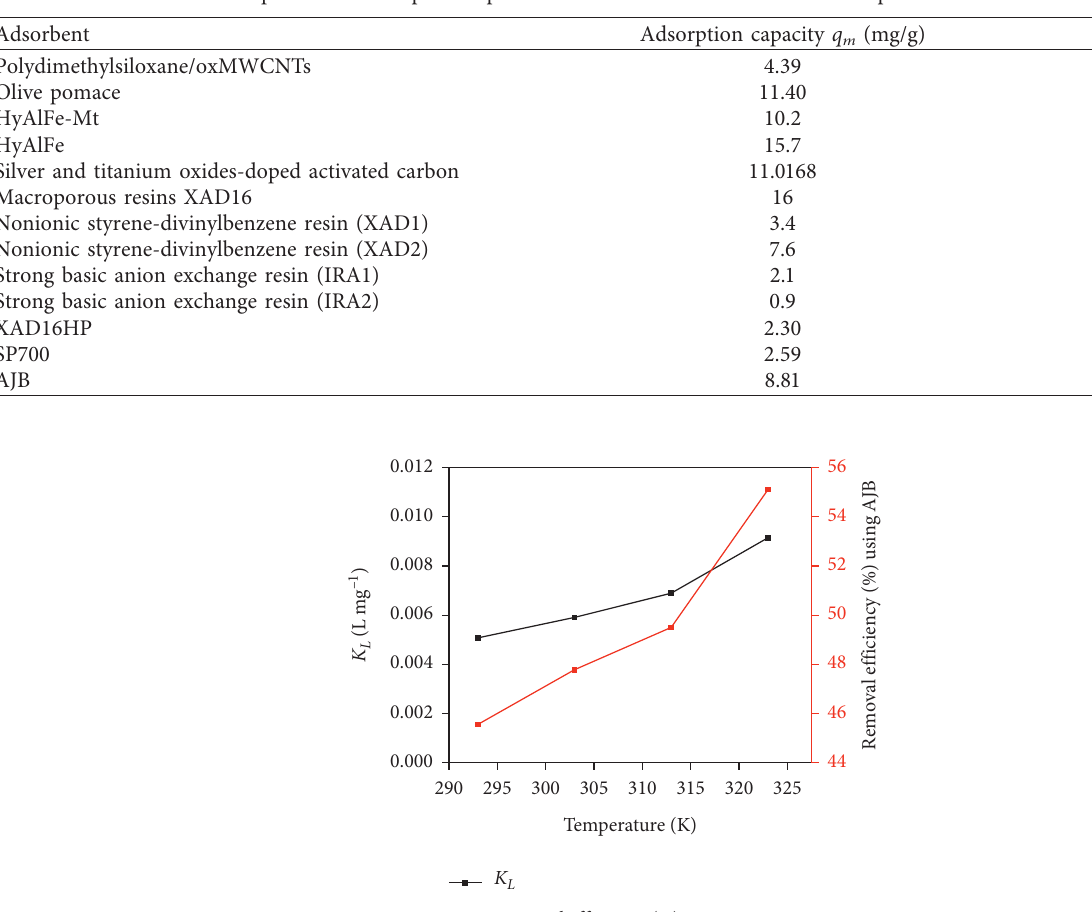
Table 4: Comparison of adsorption capacities of different adsorbents for TPC reported in the literature.